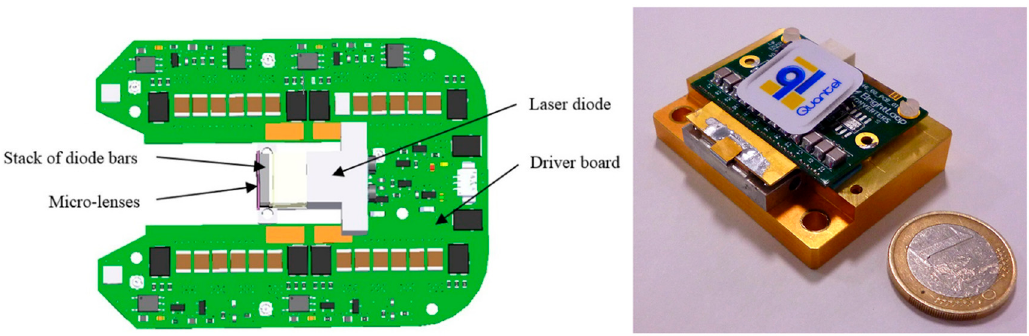
Figure 12. Schematic diagram of the diode laser source showing implementation of the laser diode within the driver board ( left ). An ultra-short pulse laser source integrating a mini-laser diode providing 1.7 mJ in pulses as short as 40 ns from Quantel, France ( right ). Adapted with permission from Proc. SPIE 9887, Biophotonics: Photonic Solutions for Better Health Care V, 98872B (2016). Copyright 2016 Society of Photo-Optical Instrumentation Engineers (SPIE).